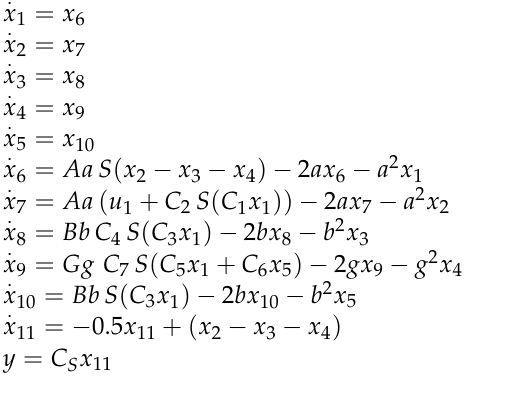
epileptic EEGs. The right-most transfer function, s/(s + 0.5), is a high pass filter which emulates the signal processing of an EEG recorder. The output, y , is the simulated EEG.